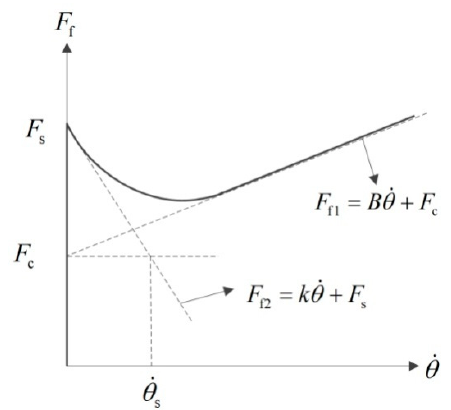
Figure 16. Force-speed curve of the Stribeck model.